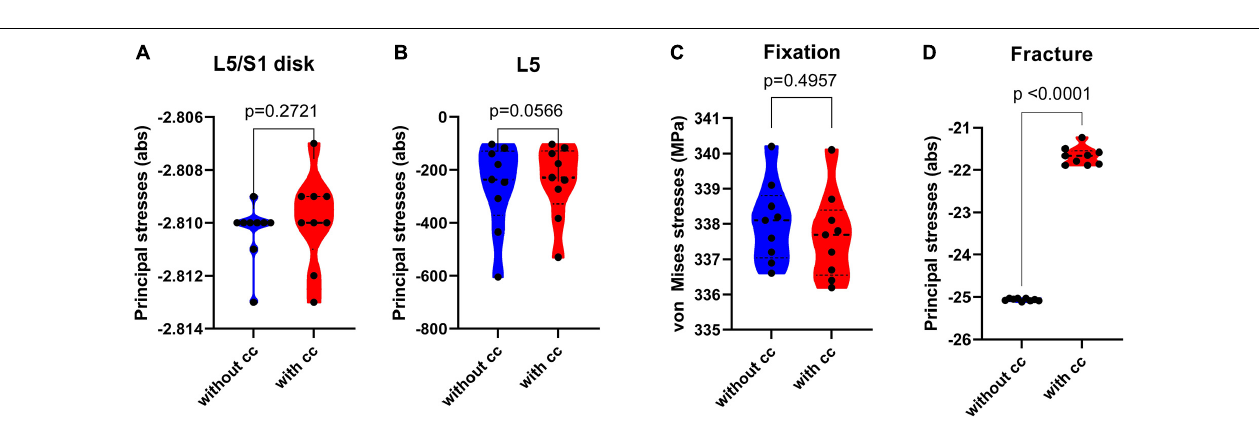
FIGURE 7 | Interfragmentary movement (IFM) in the fracture area in different conditions: Without fixation and cross connector (A) , with fixation and no cross connector (C) and with fixation and cross connector (D) , the points of measurement are depicted in (B) . In flexion, the interfragmentary movement is highest in all points and all conditions (A–D) . The fixation alone reduced the occurring interfragmentary movement substantially (C) , while an additional cross connector led to almost identical values (D) .